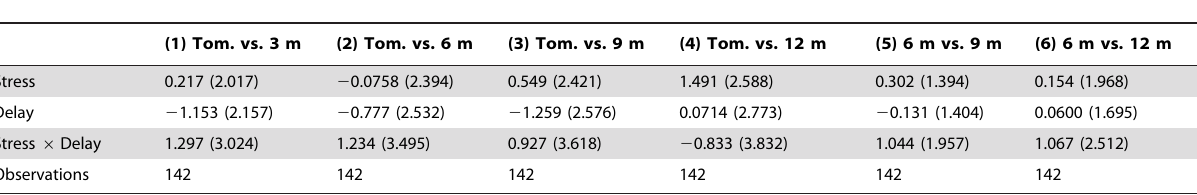
Table 4. Effect of stress manipulation on indifference points in intertemporal choice